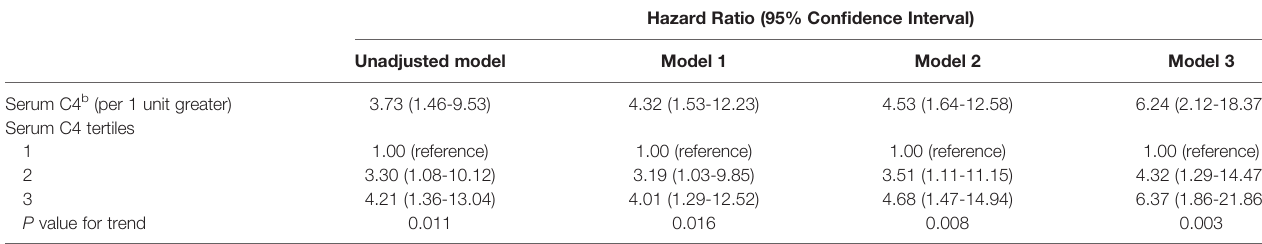
TABLE 5 | Cox proportional hazards ratio model of a renal function progression event a in the Xijing hospital.